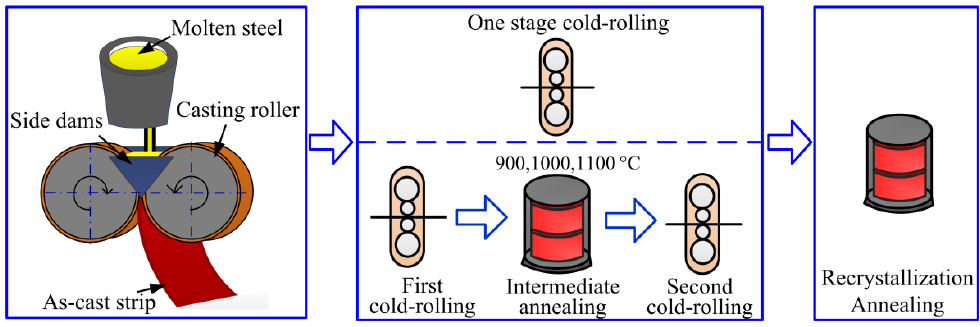
Figure 1. Schematic diagram of different processing routes for the as-cast Fe-Si alloy strip.